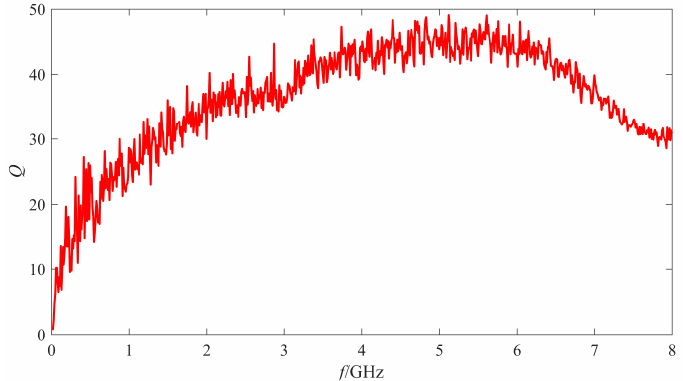
Figure 7. The quality factor (Q factor) of one fabricated MEMS suspended inductor.